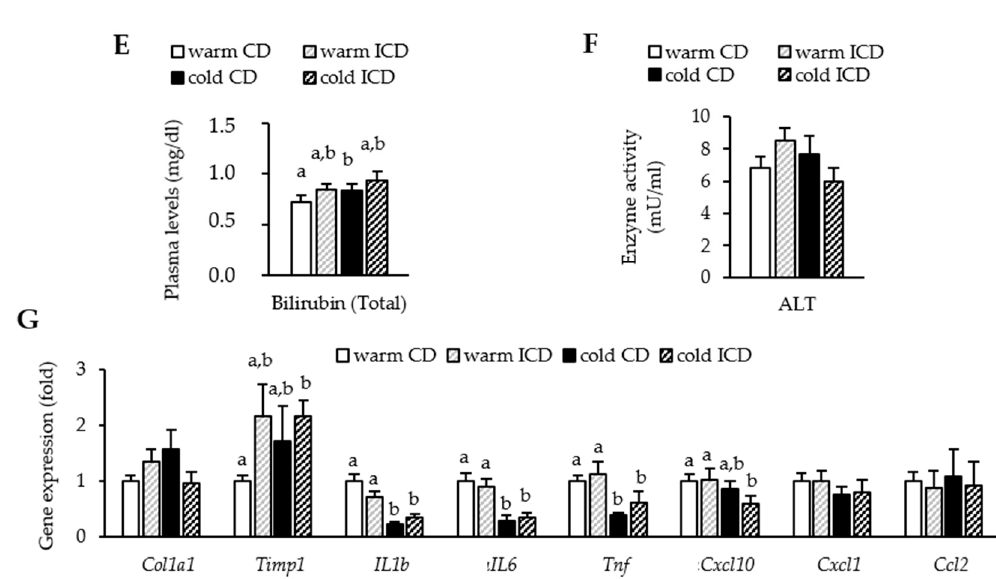
Figure 5. Inulin does not cause definite signs of liver damage. ( A ) H&E-stained (scale bar = 100 μ m) sections of livers ( B ) and liver TG levels. ( C ) Sirius Red stained sections of livers (scale bar = 200 μ m), including Sirius Red quantification ( D ). ( E ) Plasma levels of bilirubin; ( F ) plasma ALT enzyme activity; ( G ) relative hepatic expression of genes associated with liver damage, inflammation, or immune cell infiltration normalized to Tbp as the housekeeper. Data are shown as mean values ± SEM, and different letters indicate significant differences between groups ( p < 0.05) determined by two-way ANOVA. CD warm: n = 6; ICD warm: n = 6 (ICD warm bilirubin and ALT n = 5); CD cold: n = 6 (CD cold bilirubin and ALT n = 5); ICD cold: n = 5.